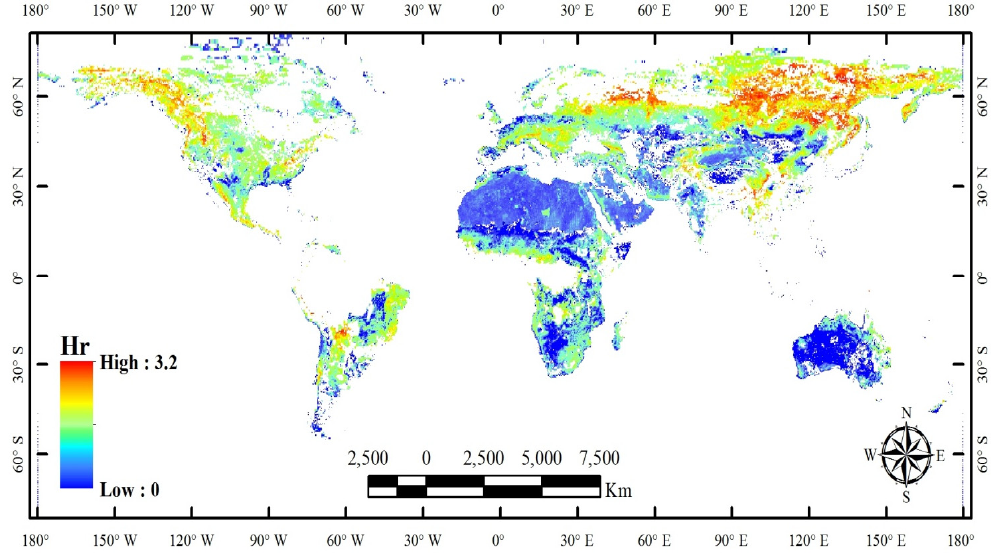
Figure 5. Global map of the retrieved roughness parameter (cid:1834)(cid:1870) at C-band (AMSR-E observations, January 2010–September 2011), for the case (cid:1843) (cid:3404) 0